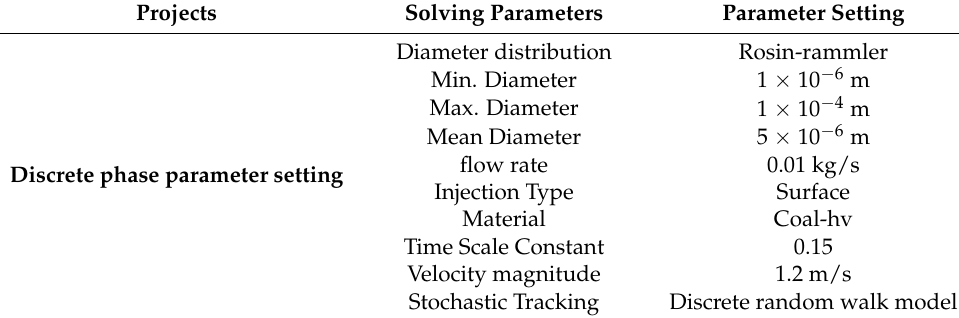
Table 3. Discrete phase parameter setting.